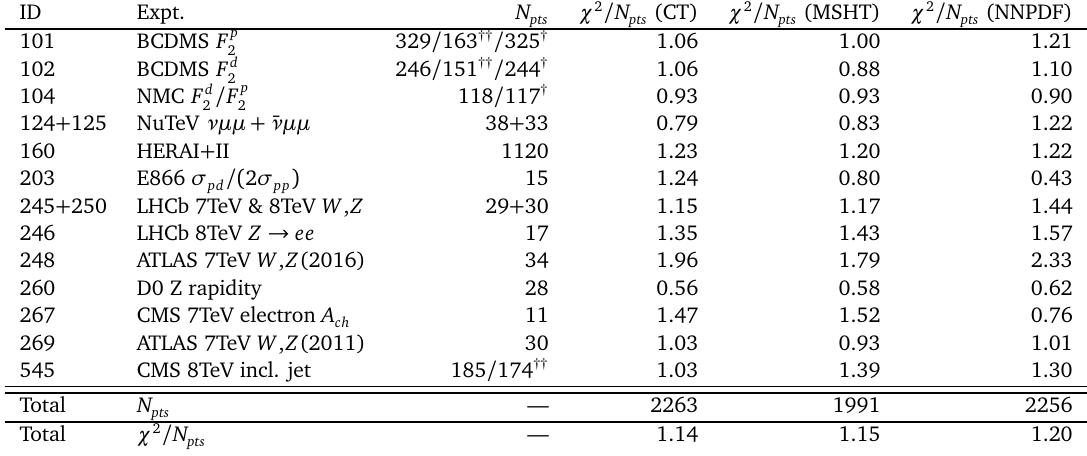
after fitting, †† MSHT † pts